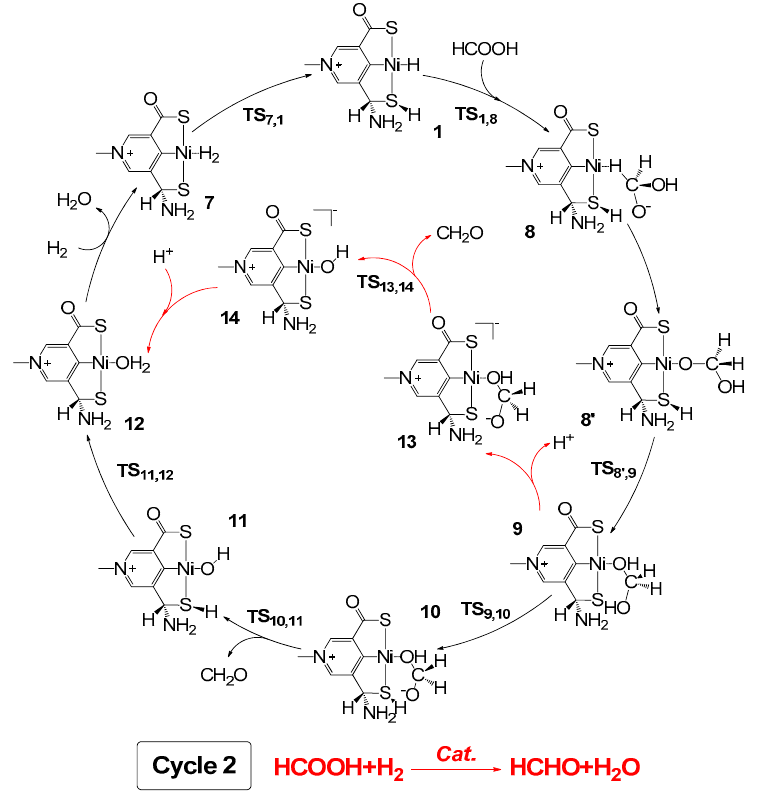
Scheme 2. Predicted mechanism for the hydrogenation of formic acid to formaldehyde and water catalyzed by 1 (Cycle 2). The deprotonation pathway is shown with red arrows.